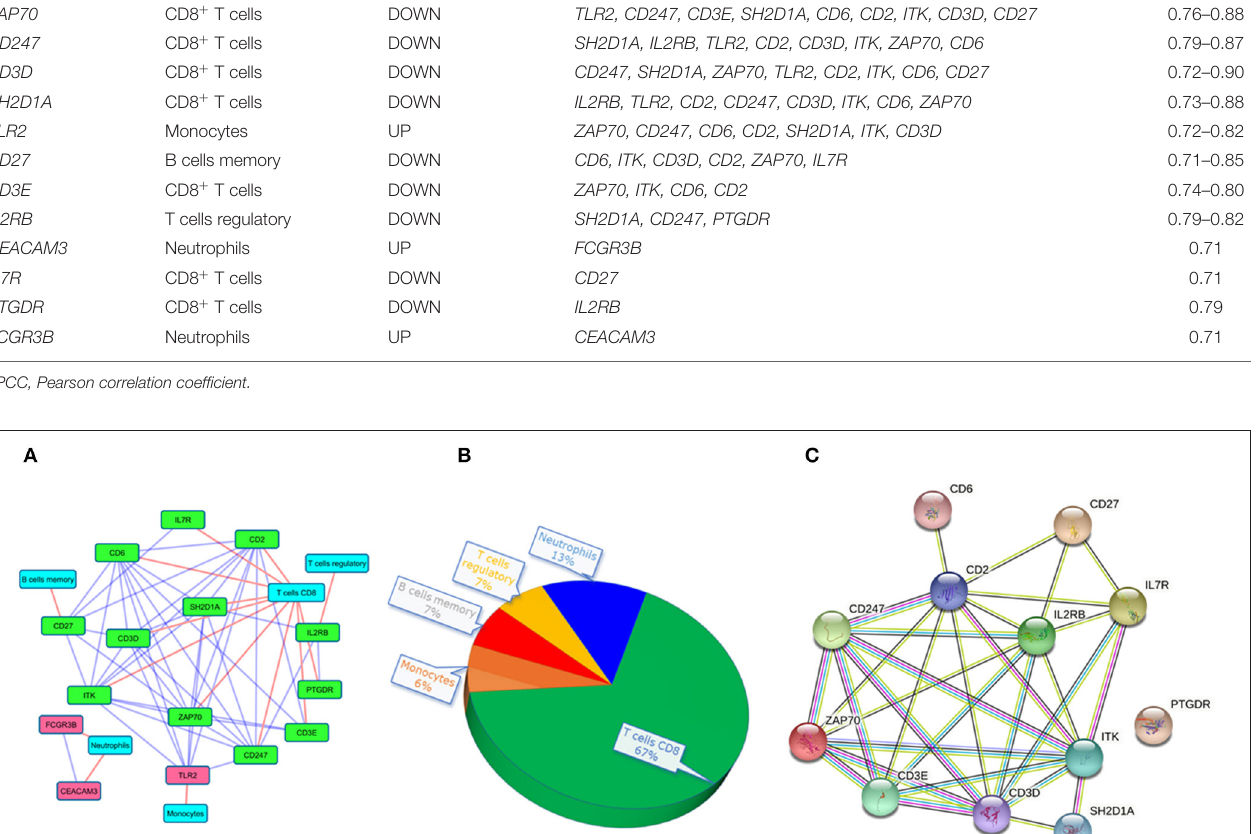
monoclonal antibodies ( Table 3 ). Hence, the integrated analysis has depicted predominant deregulation of “CD8 + T cells” as the key genetic signatures for active